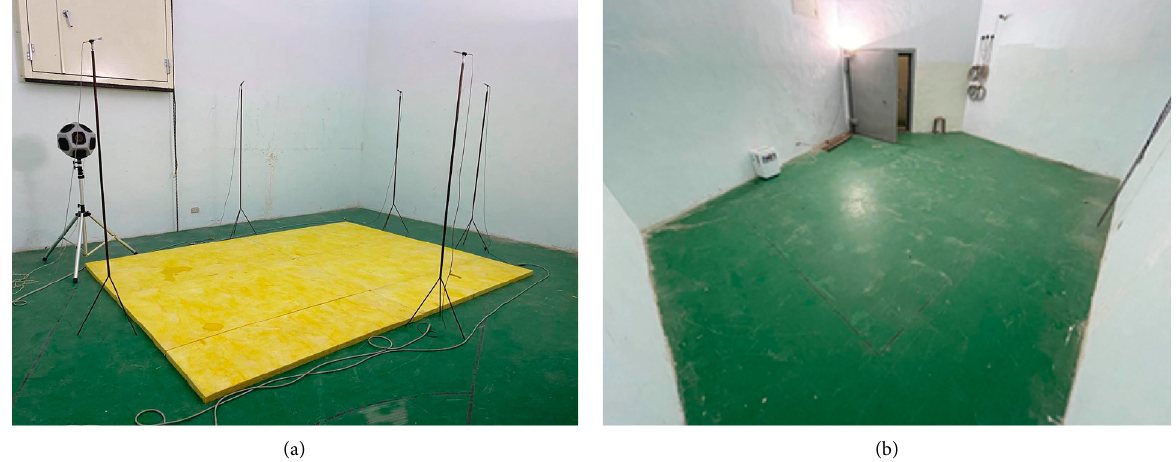
Figure 4: Measured absorption coefficient in the reverberation